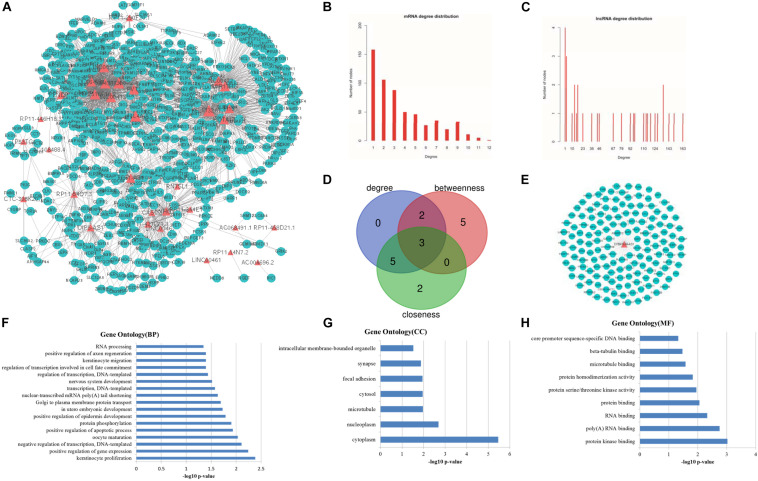
Topological features of LCLMN. (A) The overview of LCLMN. The blue nodes represented lung cancer related differential expressed mRNAs and the red nodes represented lung cancer related differential expressed lncRNAs. The size of nodes represented the degrees of the nodes in the network. (B) The node distribution of mRNAs in LCLMN. (C) The node distribution of lncRNAs in LCLMN. (D) The Venn diagram analyses showing the overlap of the top 10 max nodes with topological features in each dimension (degree, betweenness and closeness). (E) mRNAs adjacent to lncRNA EPB41L4A-AS1 in LCLMN. (F–H) The gene ontology (GO) enrichment analysis of lncRNA EPB41L4A-AS1. The x-axis was the -log10 of p-value, and p < 0.05 was considered statistically significant. LCLMN, lung cancer-related lncRNA-mRNA network.